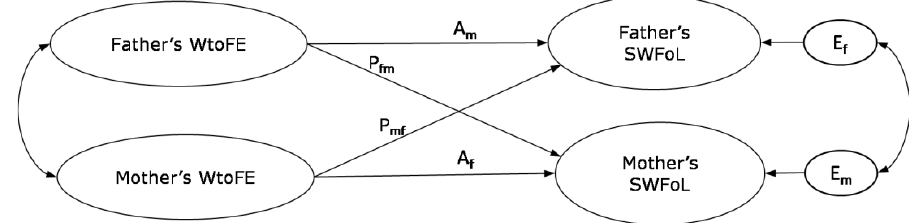
Figure 1. Basic actor – partner interdependence model of work-to-family enrichment (WtoFE) and satisfaction with food-related life (SWFoL). A m : actor effect of father’s WtoFE on his own SWFoL; A f : actor effect of mother’s WtoFE on her own SWFoL; P fm : partner effect of father’s WtoFE on mother’s SWFoL; P mf : partner effect of mother’s WtoFE on father’s SWFoL; E f and E m : residual errors on SWFoL for the father and mother,